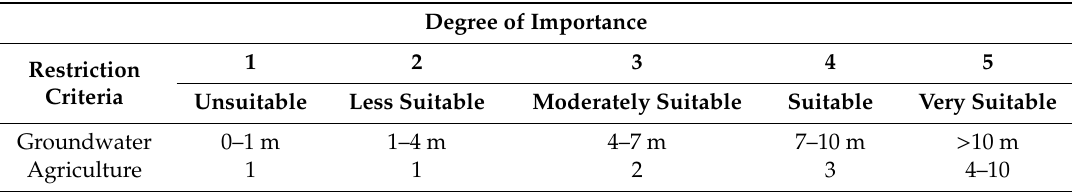
Table 6. Agriculture and groundwater standardization table for the Open case. Degree of